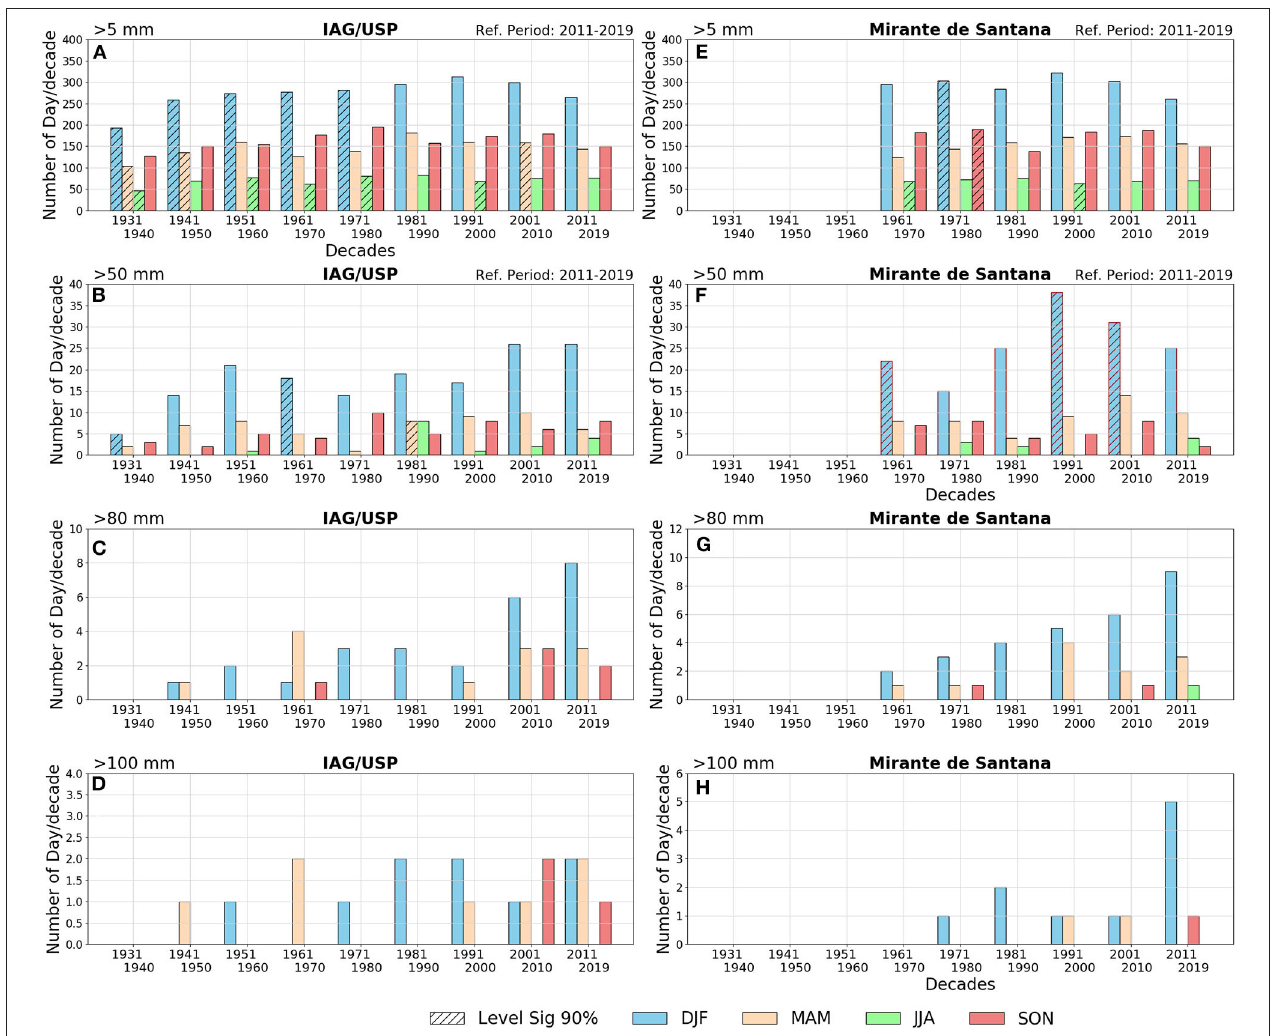
FIGURE 5 | Decadal accumulation of above 5 mm for fore the four seasons of the year in (A) IAG-USP and (E) Mirante de Santana; for numbers of days with precipitation above 50 mm for (B) IAG-USP and (F) Mirante de Santana; for number of days with precipitation above 80 mm (C) IAG-USP and (G) Mirante de Santana, and number of days with precipitation above 80 mm (D) IAG-USP and (H)